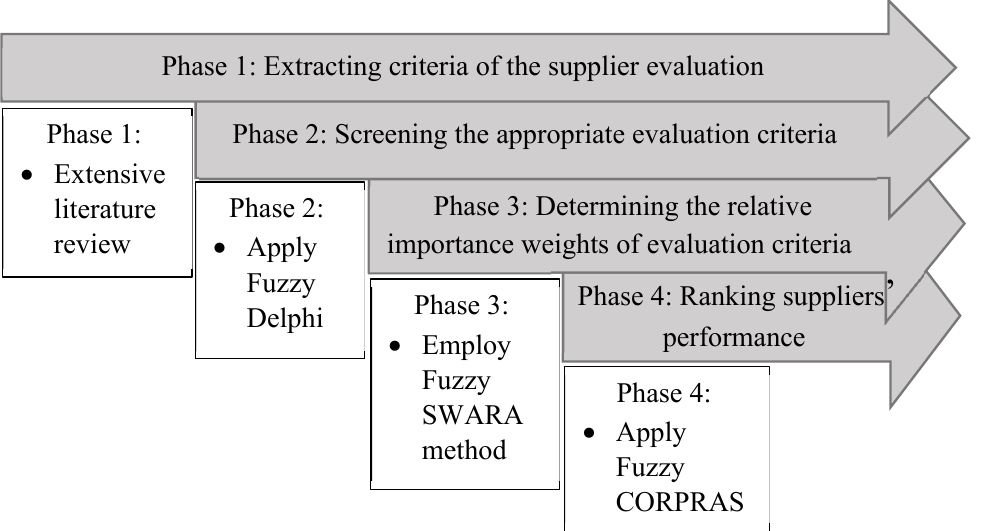
Fig. 3. Research framework for supplier selection on VMI in